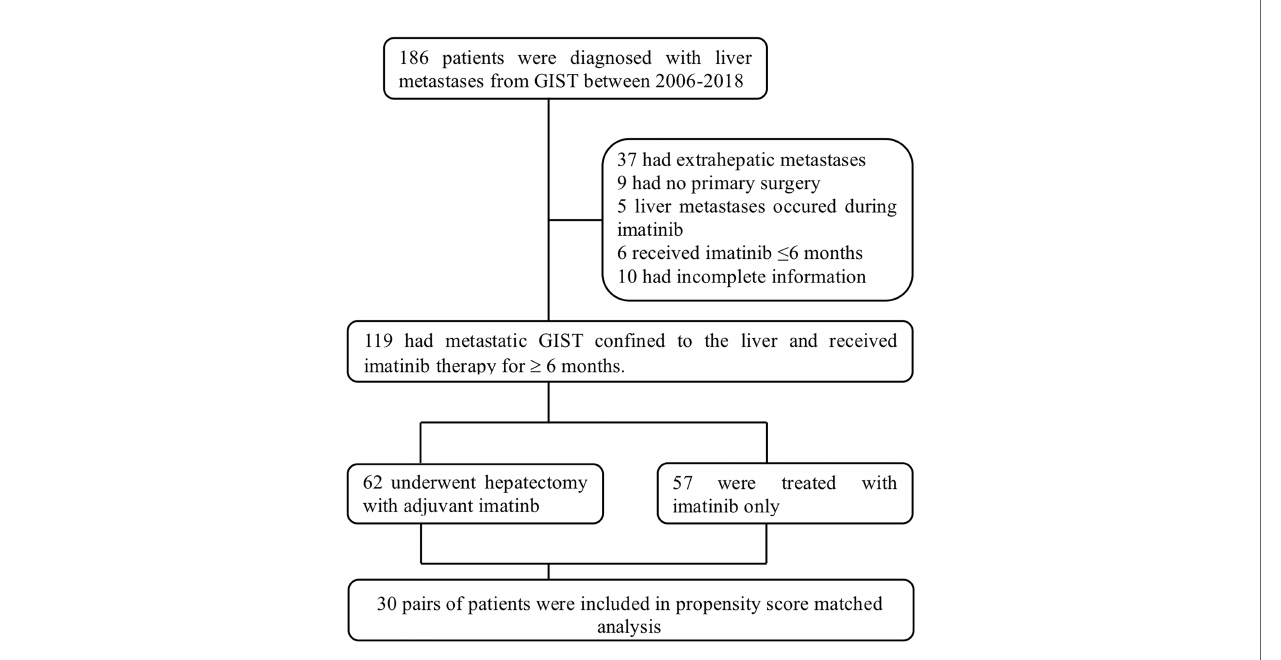
FIGURE 1 | Flow chart of the patients included in this